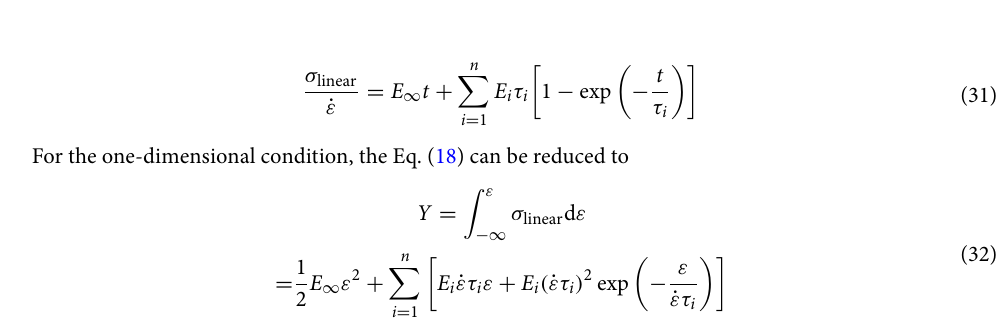
Figure 8. The relaxation modulus curve and fitted result.